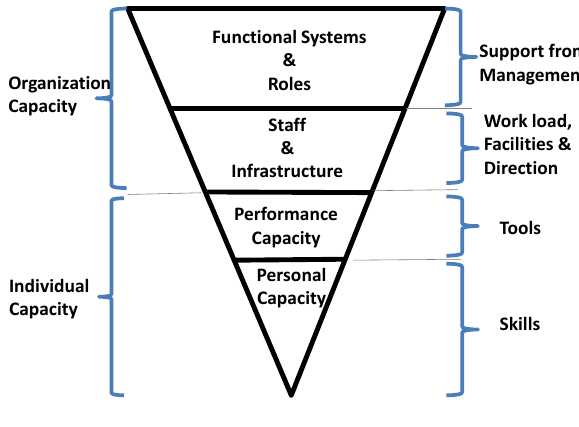
Fig 1. Capacity building frame work of an